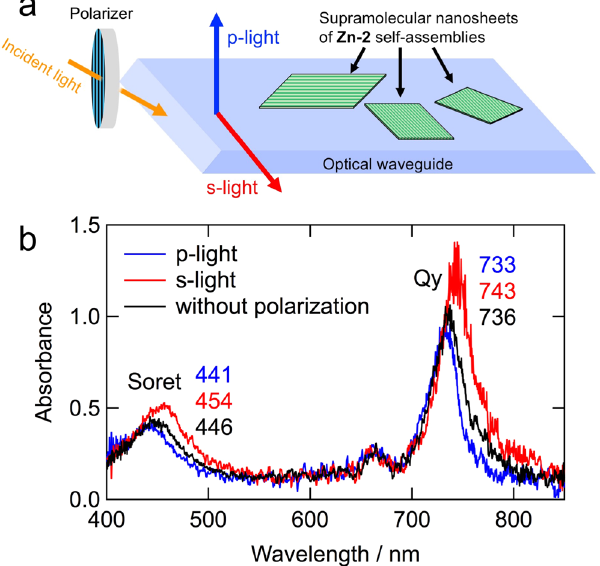
Figure 5. Vis-NIR absorption spectra of Zn-2 nanosheets using optical waveguide. ( a ) Schematic of the measurement and ( b ) Vis-NIR absorption spectra of Zn-2 nanosheets on an optical waveguide using p- (blue) and s-light (red) as well as non-polarized light (black).